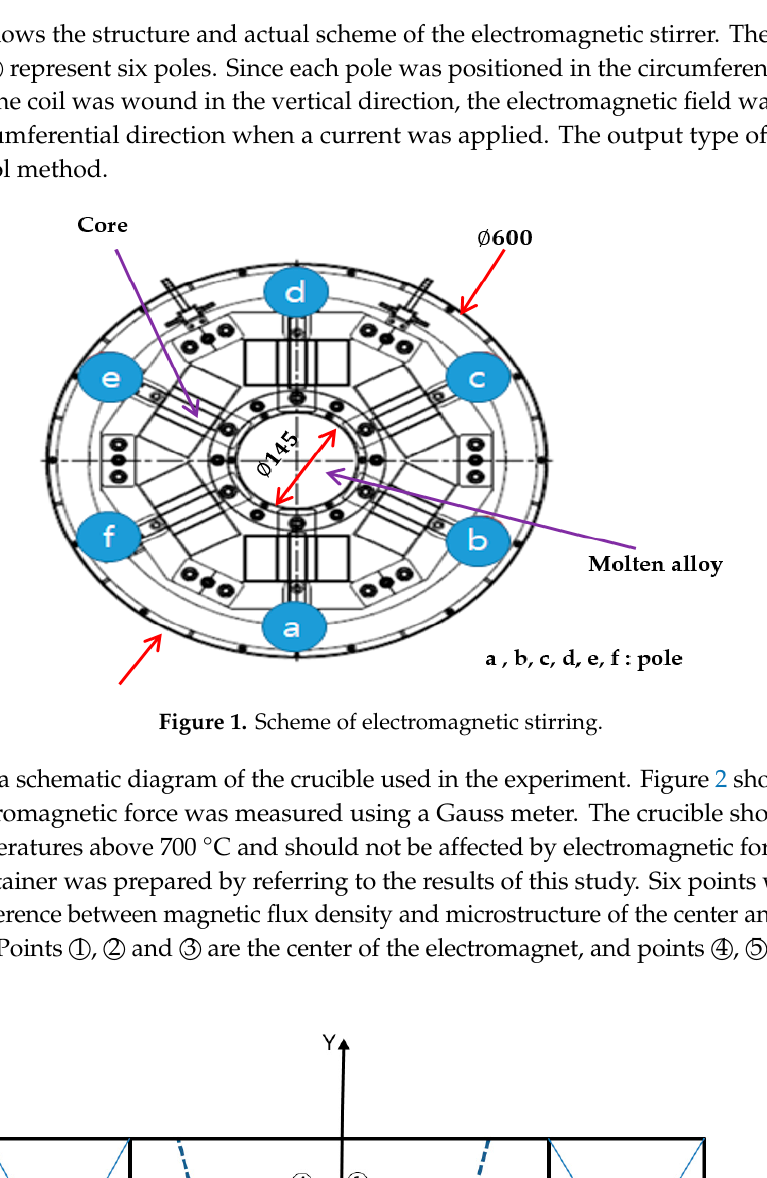
A 356 Figure 3. Change in solid fraction with temperature of A356. 2.2. Experimental Method